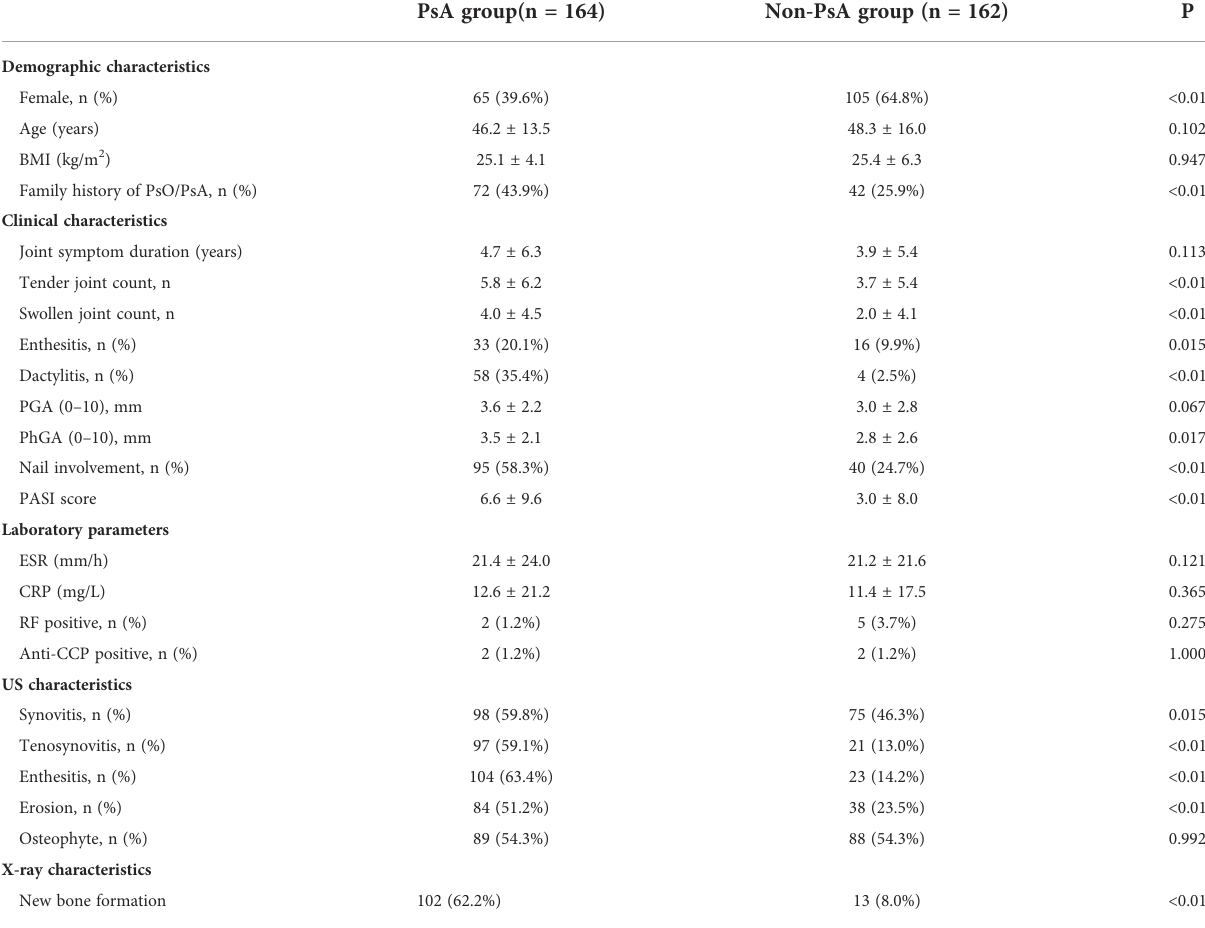
TABLE 1 Comparisons of the demographics and clinical features between PsA and non-PsA